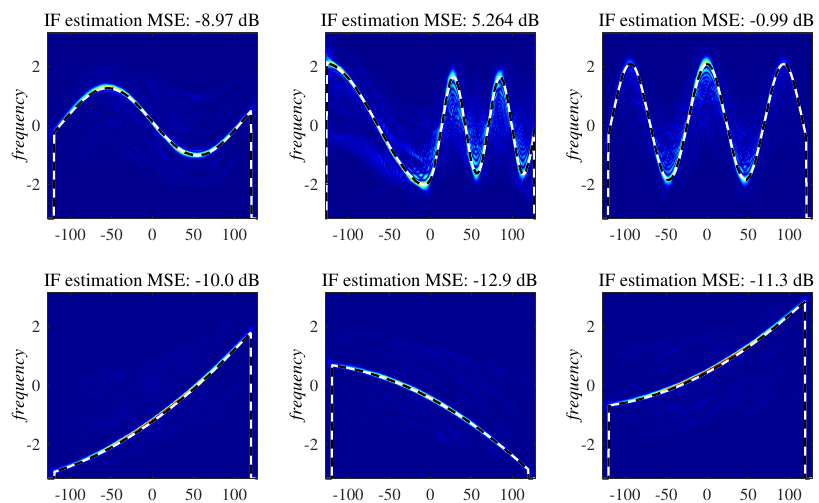
Figure 14. Instantaneous frequency estimation for individual signal components based on the extracted signal components (dashed black) and the original signal components (solid white). MSEs between the two IF estimates is provided for each component of the signal from Example 3. The noise variance is σ 2 ε = 1. Decomposition is based on C = 256